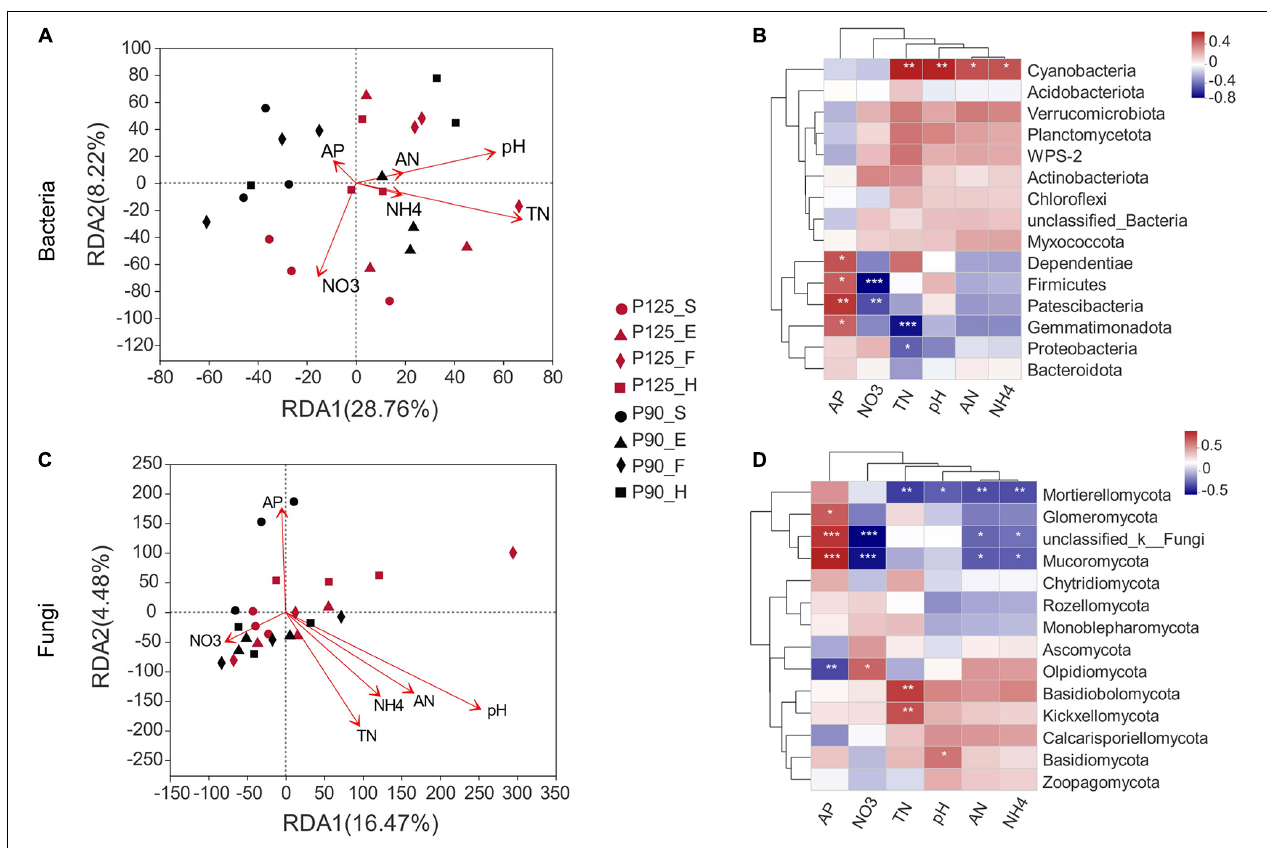
FIGURE 4 | Correlation of soil microbial community structure–environmental factors–specific microorganisms by redundancy analysis (RDA) and heatmaps. (A,B) Bacterial community structure. (C,D) Fungal community structure. Soil properties included available P ( AP ), pH, available N (AN), total N (TN), ammonium N (NH 4 ), and nitrate N (NO 3 ). The direction of the arrow represents the correlation with the first two-gage axes; the length of the arrow indicates the strength of the correlation. Colors in the heatmap indicate different correlation thresholds ( R ), and the color interval is shown in the upper right legend. P -values are used to express significance. *0.01 < p ≤ 0.05; **0.001 < p ≤ 0.01; *** p ≤ 0.001. P125 , treatment of 125 kg P 2 O 5 ha − 1 ; P90 , treatment of 90 kg P 2 O 5 ha − 1 ; S , seedling stage; E , ear stage; F , flowering stage; H , harvest